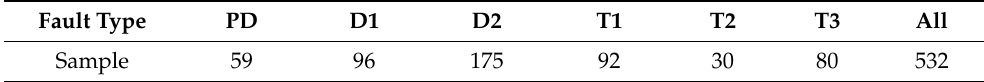
Table 1. Number of samples for each fault type.